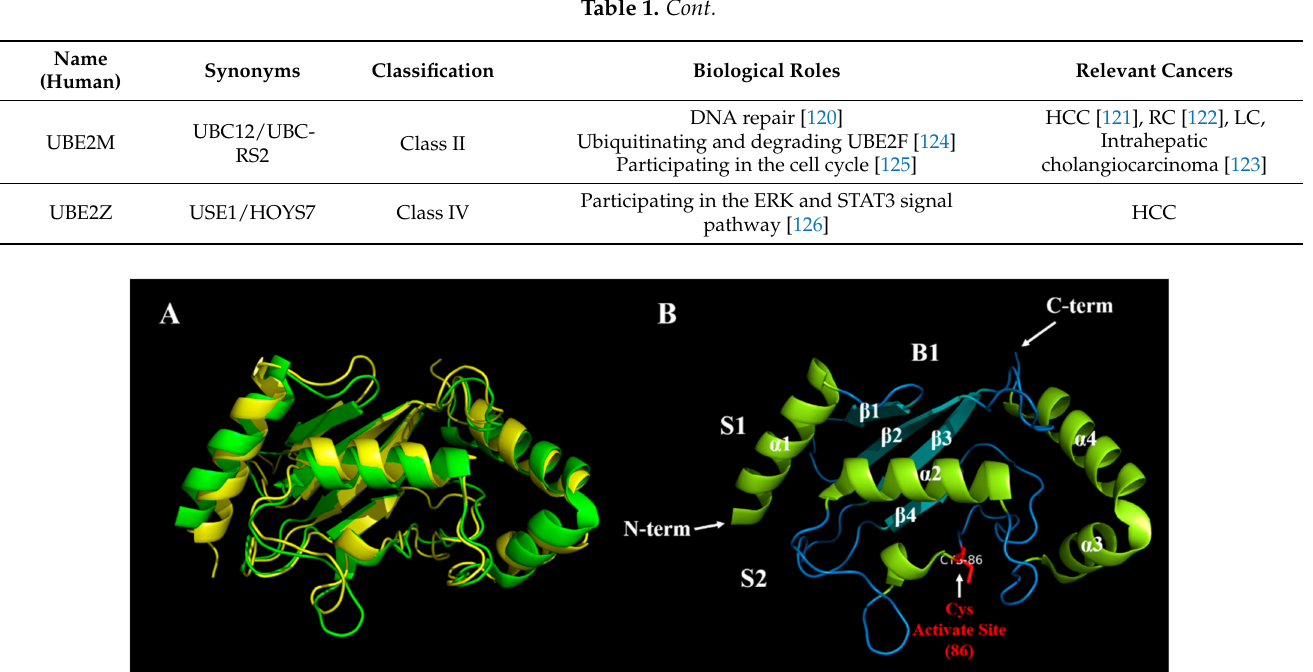
Figure 2. ( A ) The alignment of UBE2T and UBE2I (Ubl). The three dimensional (3D) structure of UBE2T is shown in green, while UBE2I is shown in yellow, indicating that the structure of E2 family is conserved. UBE2T has a C-terminal extension, which belongs to Class III, while UBE2I has no C- and N- extensions, and so belongs to Class I, which are consistent with the summary shown in Table 1 ( B ) The 3D structure of UBE2T. We marked four α -helixes and four β - folds with white letters. N-term and C-term refer to the N- and C-termini of UBE2T, respectively. The main sites of interaction between UBE2T and E1 and E3 are S1 and S2, respectively, and the active site cysteine (86) is highlighted in red. B1 is opposite to the active site of UBE2T, which is called the ‘backside.’ Backside binding between E2 and Ub or SUMO contributes to chain building activities or regulates E2 activities via allostery [32]. The 3D structures of UBE2T and UBE2I were downloaded from http://www.rcsb.org/ (accessed on 20 November 2020), numbered 5NGZ and 1A3S, respectively. PyMOL software was used to align them, and the prediction of the active site was carried out using http://www.ebi.ac.uk/interpro/result/InterProScan/iprscan5-R20200618-032207-0413-15289371-p2m/ (accessed